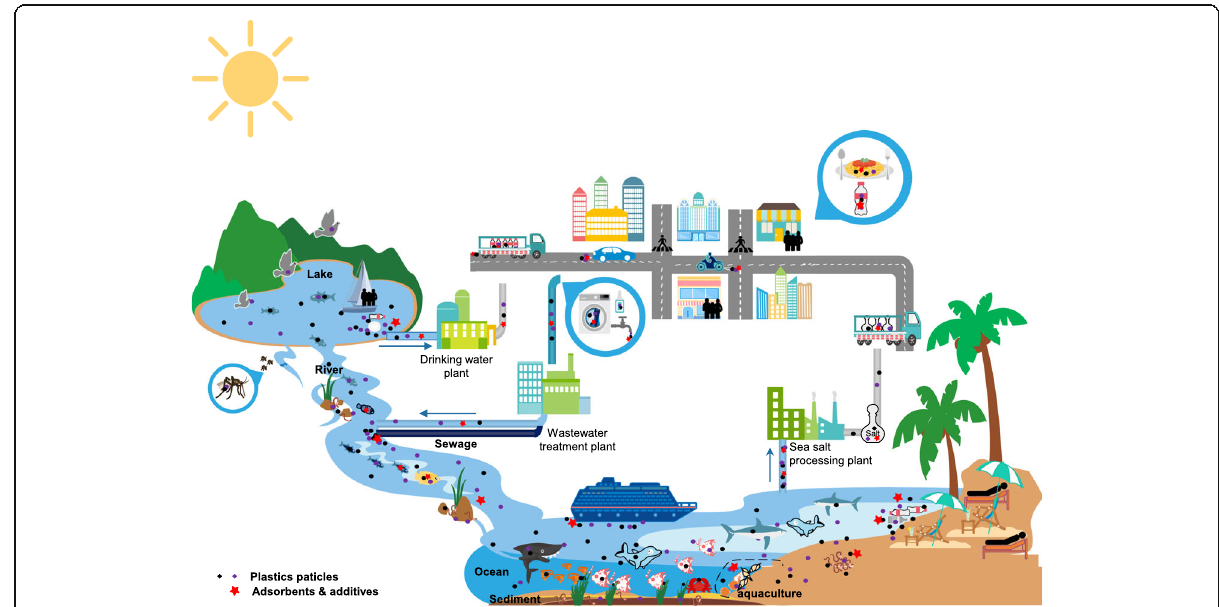
Fig. 2 A summary of sources, transports, and exposure routes of micro- and nanoplastics